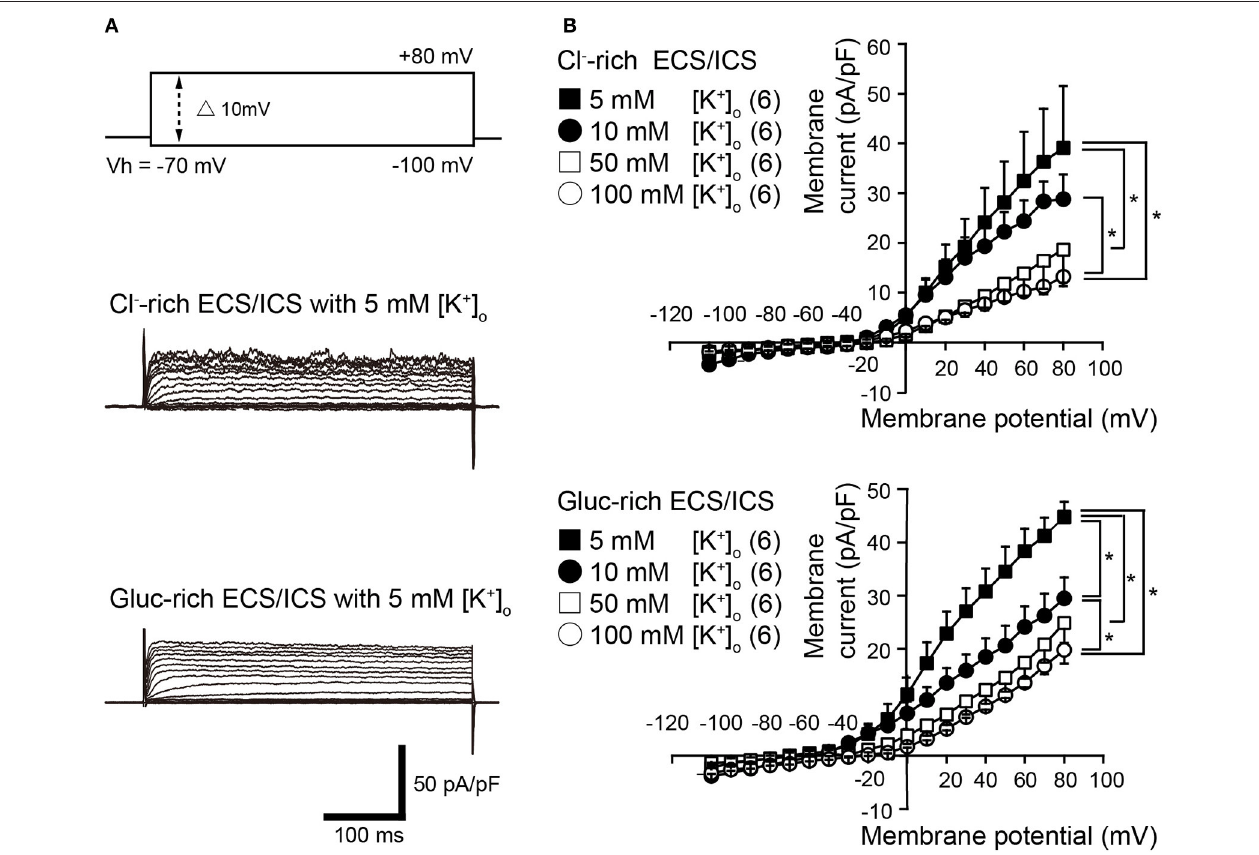
FIGURE 1 | Outwardly rectifying currents in odontoblasts. (A) Representative current traces with extracellular 5mM [K + ] o recorded in Cl − -rich extracellular and intracellular solutions (Cl − -rich ECS and ICS) (middle traces), as well as in gluconate-rich ECS and ICS (Gluc-rich ECS and ICS) (lower traces) are shown. Currents were evoked by 400ms voltage-steps from − 100 to + 80mV in 10mV increments from a Vh of − 70mV (upper traces). (B) Current-voltage (I-V) relationships for the current recorded in Cl − -rich ECS and ICS (upper), and gluc-rich ECS and ICS (lower) with 5mM [K + ] o (filled squares), 10mM [K + ] o (filled circles), 50mM [K + ] o (open squares), and 100mM [K + ] o (open circles). Each point indicates the current density for the mean ± SD from each of the 6 cell. Statistically significant differences between points at a membrane potential of + 80mV (shown by solid lines) are indicated by asterisks, * P <